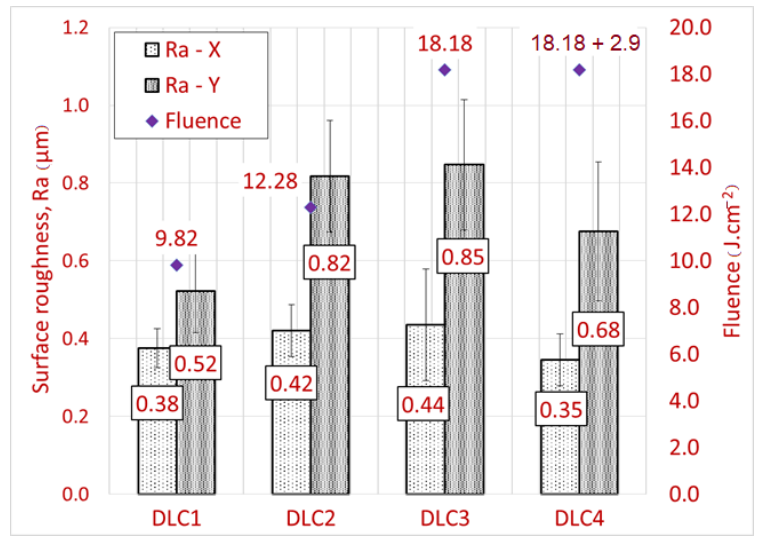
Figure 8. Bar chart of surface roughness after laser stripping of the DLC C coatings in relation to the fluence.